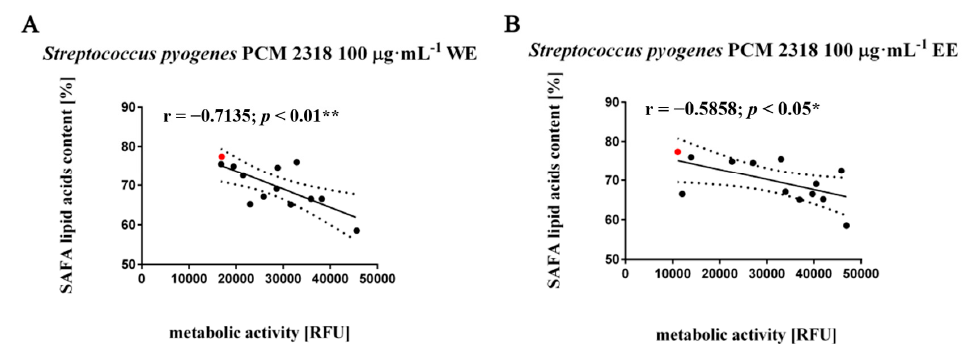
Figure 3. Effect of saturated fatty acids (SAFA) ( A , B ); on metabolic activity of Streptococcus pyogenes PCM 2318. Twelve water or ethanol extracts with defined concentrations of 1 mg·mL − 1 , 100 μ g·mL − 1 , 10 μ g·mL − 1 (black dots) were considered. WT cells are marked with a red dot. Results represent the mean from three independent experiments. The 95% confidence interval is shown. Correlation analysis of the data was performed using a Linear Correlation (Pearson r) test.